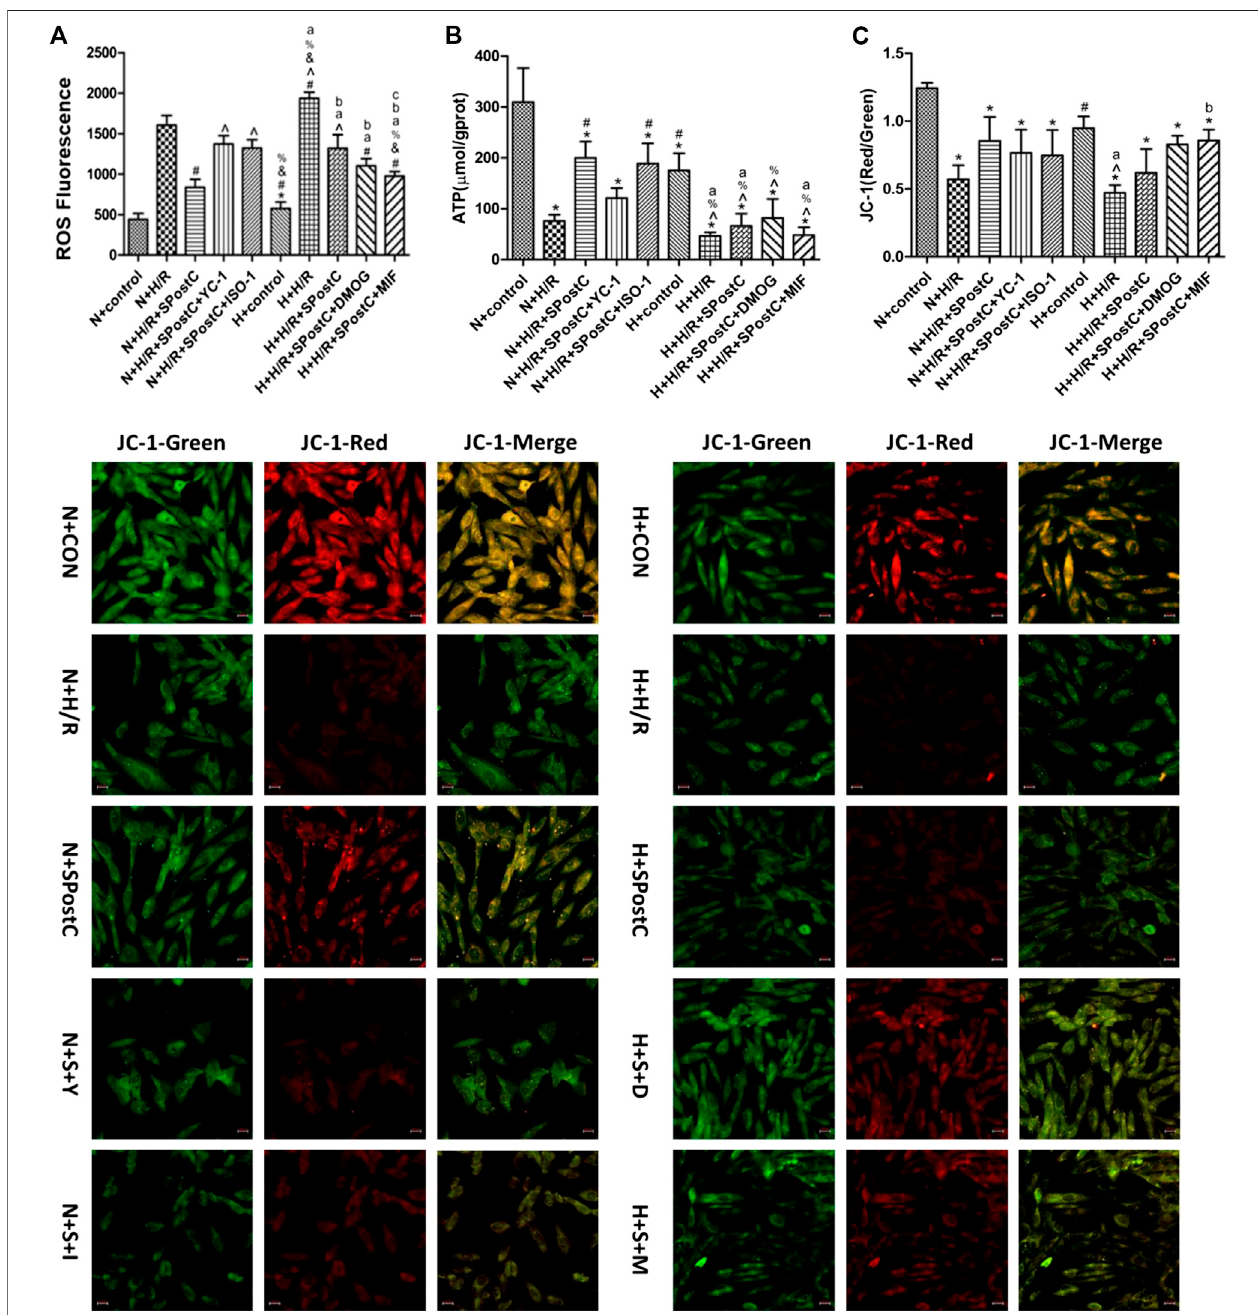
FIGURE 5 | Regulate HIF-1 α /MIF/AMPK signaling pathway restored SPostC-induced cardioprotective effects in a high glucose condition. (A) ROS synthesis: ComparedwithN+H/Rgroup,N+H/R+SPostCgroupreducedROSsynthesis,butH+H/R+SPostCgroupfailedtoreduceROSsynthesis;Compared withN+H/R + SPostC group, YC-1 group and IOS-1 group promoted ROS synthesis; Compared with H + H/R + SPostC group, DMOG group and MIF20 group reduced ROS synthesis (n (cid:2) 3/group). (B) ATP content: Compared with N + H/R group, N + H/R + SPostC group signi fi cantly increased ATP content, but H + H/R + SPostC groupATPcontentdecreased;comparedwithN+H/R+SPostCgroup,YC-1groupandIOS-1groupdecreasedATPcontent;comparedwithH+H/R+SPostCgroup Compared with DMOG group and MIF20 group, ATP content increased (n (cid:2) 3/group). (C) Representative images of JC-1 were capture using a fl uorescence inverted microscopeincardiomyocytes(200 × ).TheresultsshowedthatHIF-1 α agonistDMOGandMIFagonistMIF20increasedtheratioofredtogreen fl uorescenceintensity(n (cid:2) 3/group). Datarepresent mean ± SD,vs. N+CONgroup * p < 0.05; vs.N+H/R group# p < 0.05; vs.N+H/R +SPostCgroup ^ p < 0.05;vs. N+H/R+SPostC +YC-1 group& p < 0.05; vs.N+H/R+SPostC +ISO-1 group% p < 0.05;vs.H+controlgroup a P < 0.05;vs.H+H/Rgroup b P < 0.05;vs.H+H/R+SPostCgroup c P < 0.05.